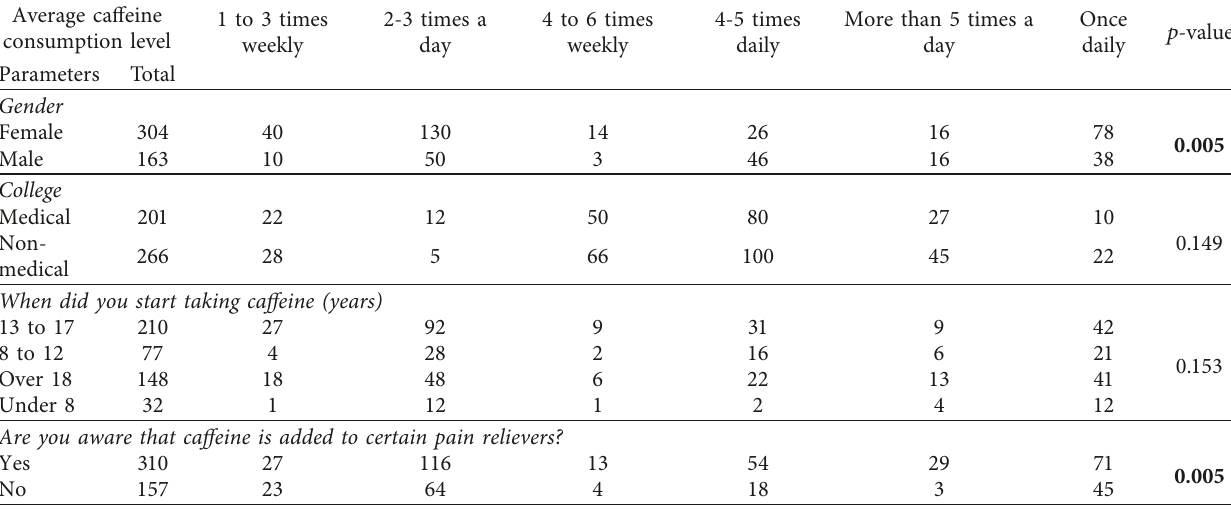
Table 3: Average consumption level.